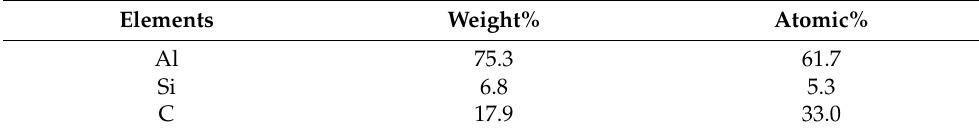
Figure 2. EDS spectrum of Al + 5%SiC reinforced composites. Table 4. List of elements found in the Al + 5%SiC reinforced composites.